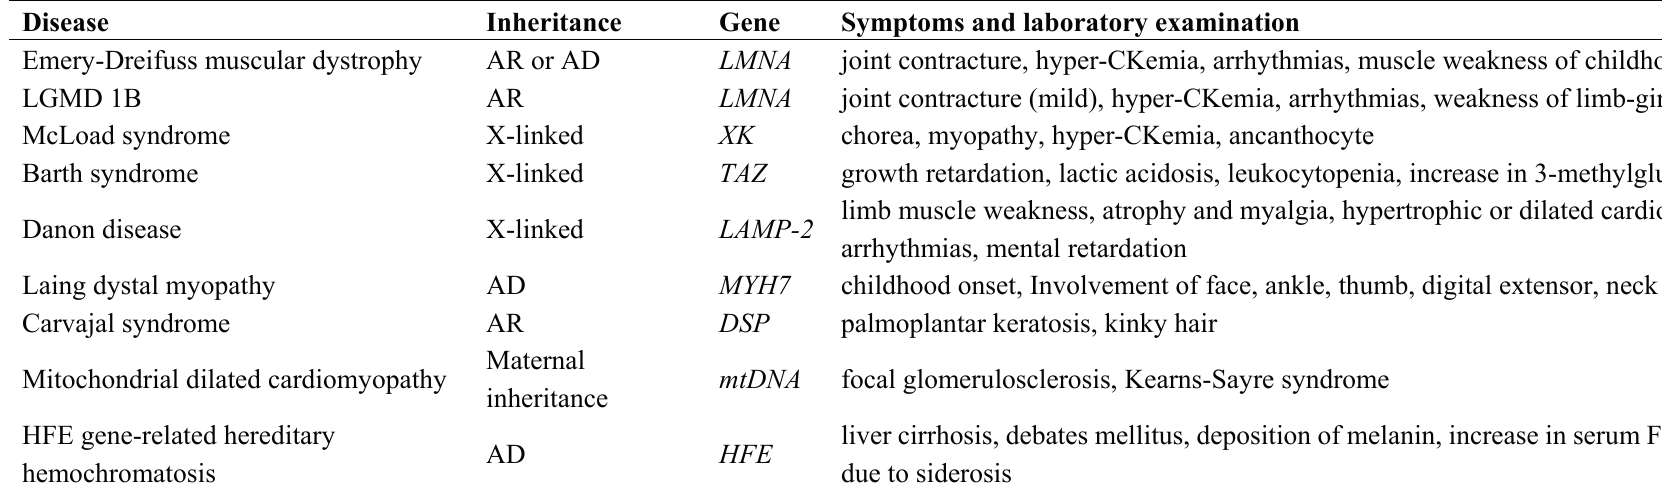
Table 2. Differential diagnosis of X-linked dilated